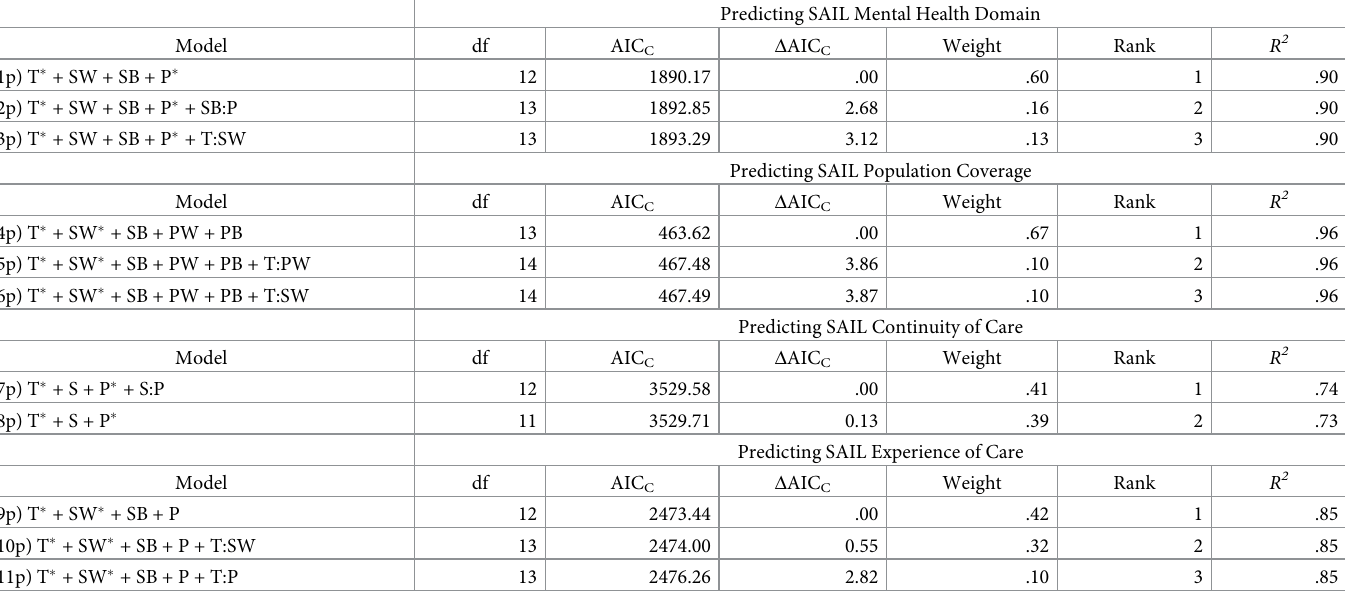
Table 2. Top models ( Δ AIC C < 4) predicting SAIL mental health